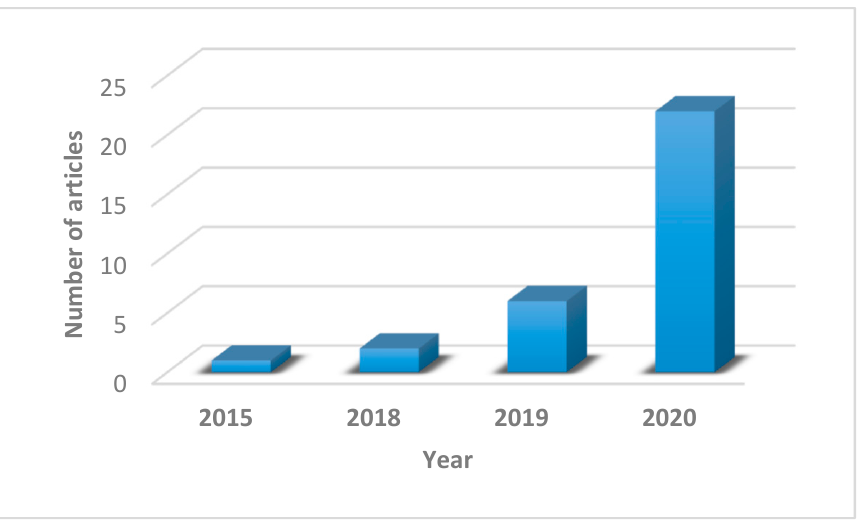
Figure 7. Distribution of the selected articles according to the indicated year.